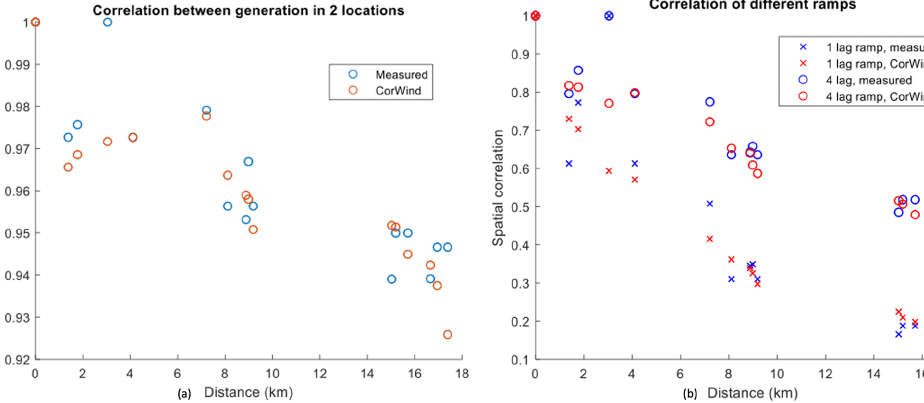
Figure 9. (a) Correlation of power production vs. distance between two plants. (b) Correlation of power ramps vs. distance between two plants for 15min (1 lag) and 60min (4 lag).